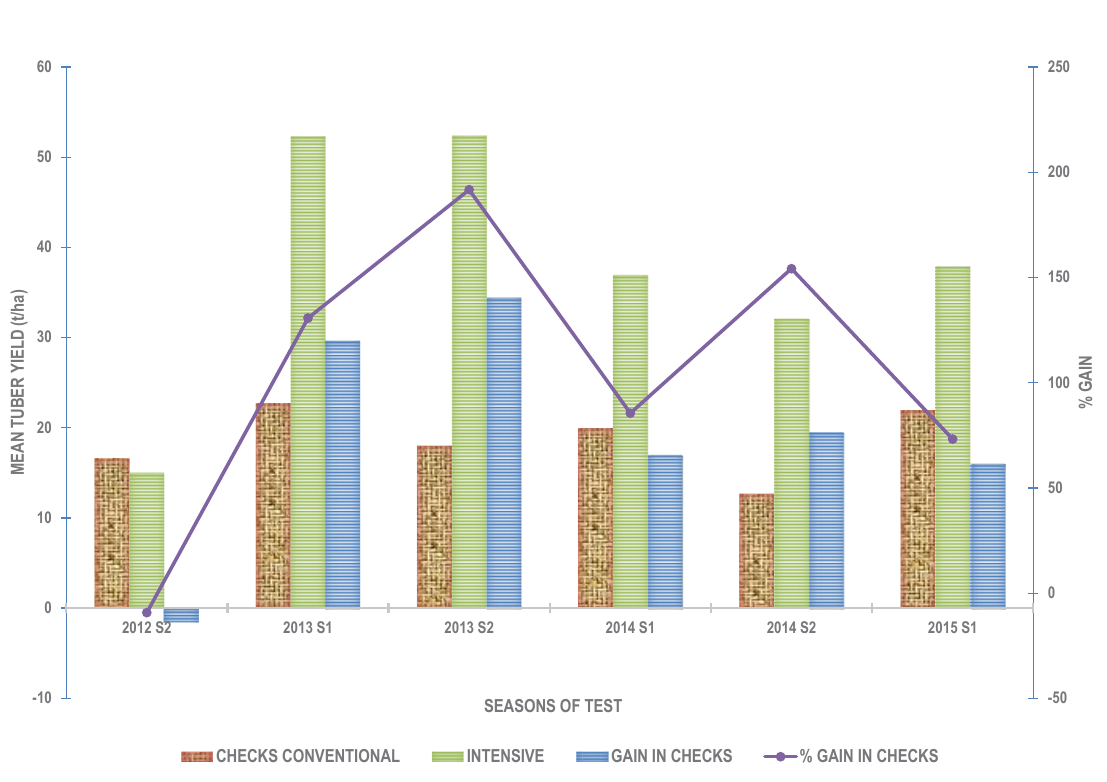
Figure 5: Tuber yields of checks in conventional and when in intensive